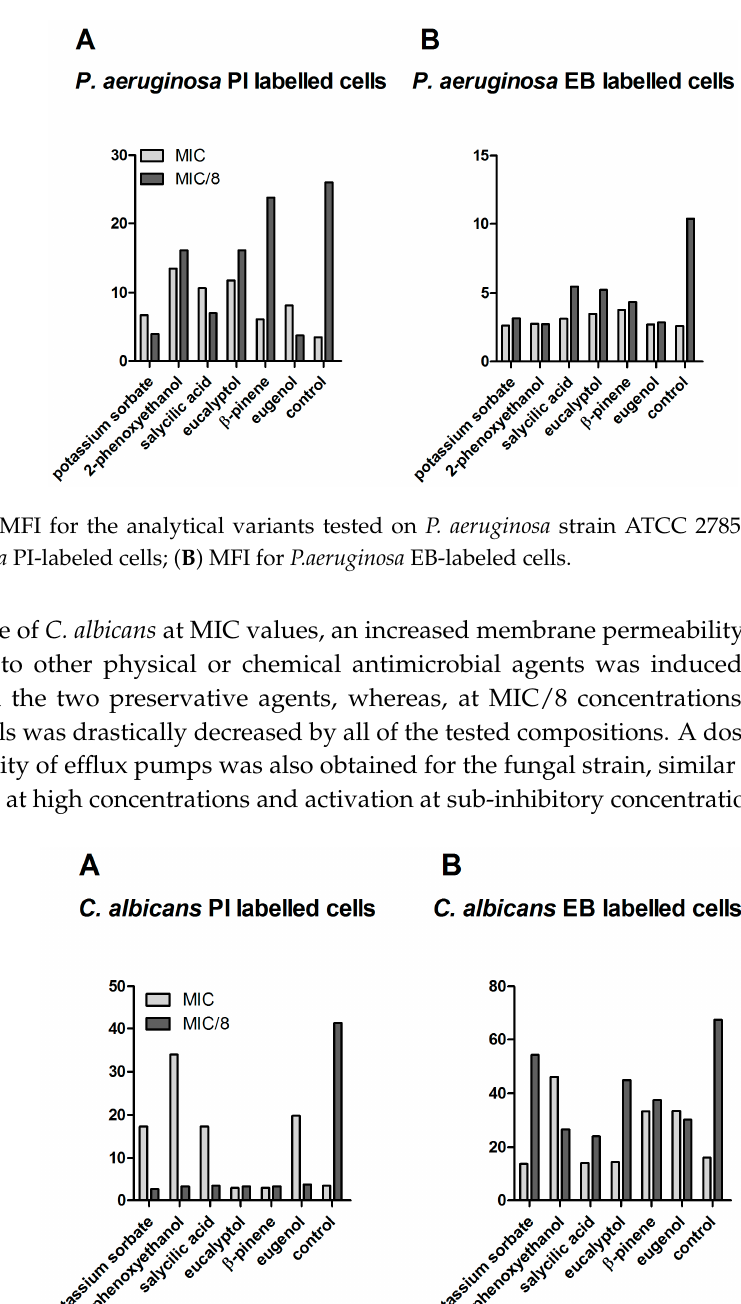
Figure 4. MFI for the analytical variants tested on C. albicans strain ATCC 10231. ( A ) MFI for C. albicans PI-labeled cells; ( B ) MFI for C. albicans EB-labeled cells.